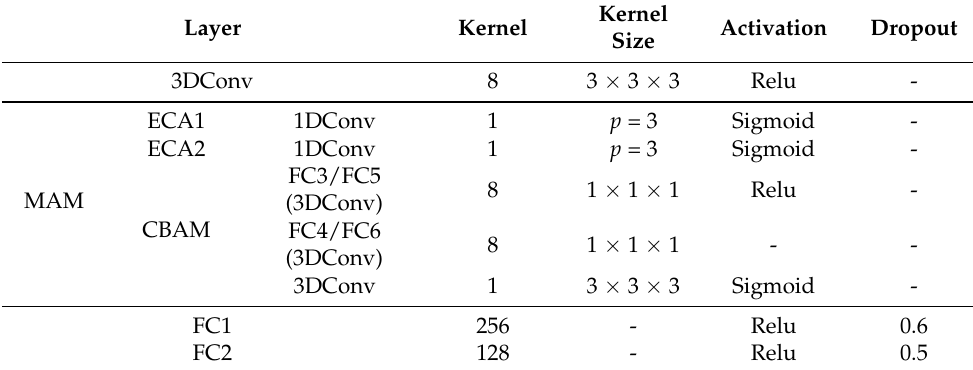
Figure 11. Comparison of classification accuracy under different r s. The best result of the OA, AA, and Kappa can be obtained when r = 1. Table 2. Internal parameter setting of the MAM-3DCNN.